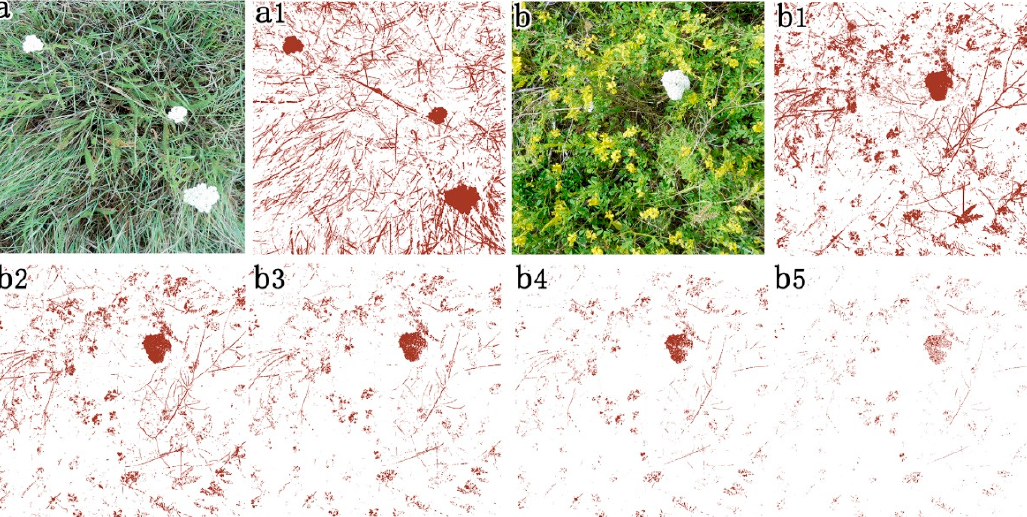
Figure 8. Flower effects on the extraction of standing dead matter (SDM) from RGB images. ( a ) RGB image taken in valley grassland. ( a1 ) Extraction of SDM from ( a ) with 𝑑 = 1. ( b ) RGB image taken in disturbed communities. ( b1 – b5 ) Extraction of standing dead materials from ( b ) with 𝑑 = 1, 1.5, 1.7, 1.8 and 1.9, respectively.